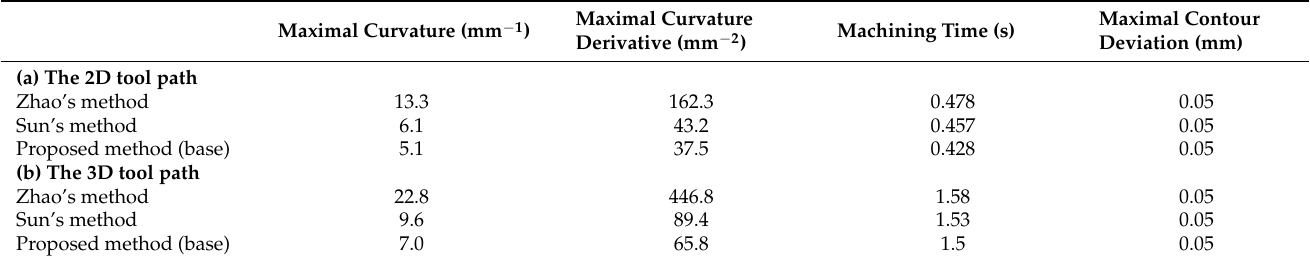
Table 1. The comparison between three methods.